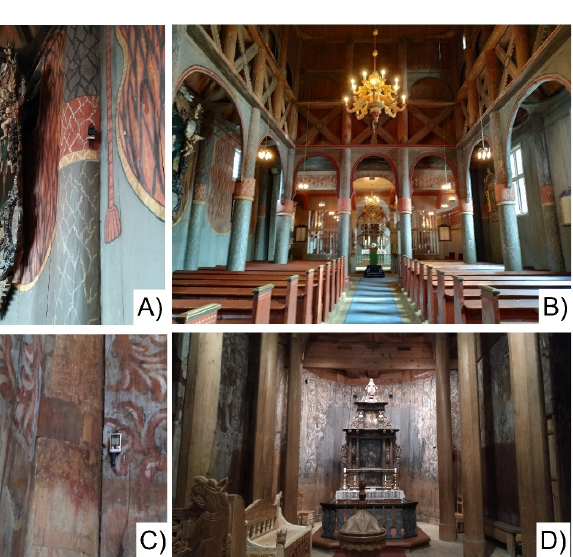
Figure A1. Indoor of Ringebu ( B ) and Heddal ( D ) stave churches: wooden building assets and altars are visible. The sensors positioned in Ringebu ( A ) and Heddal ( C ) are shown as well.